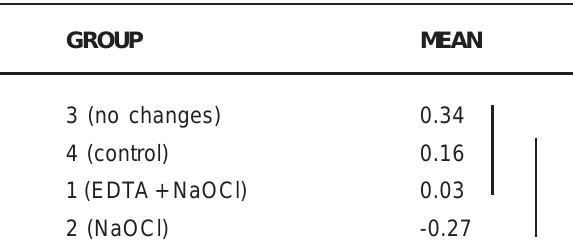
OBS. Vertical bars indicate statistical